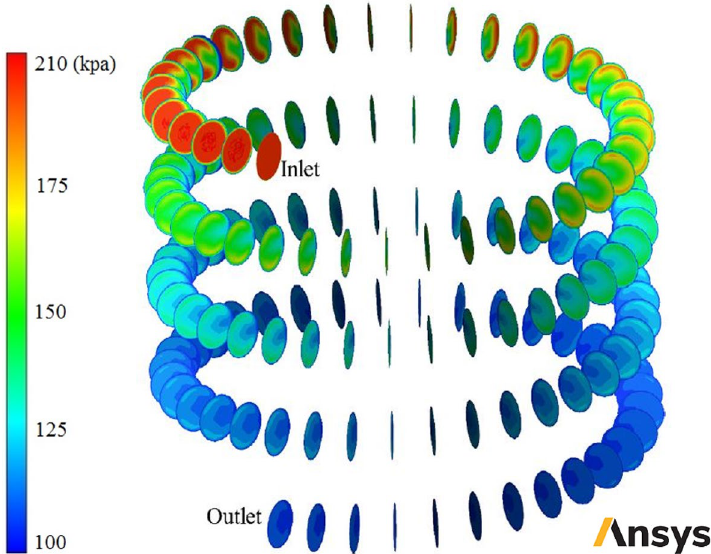
Figure 7. Pressure contours in some cross-sections of smooth-wall helical heat exchanger filled with two-phase NNNF ( φ = 1% and d np = 20 nm) (Images used courtesy of ANSYS, Inc.).